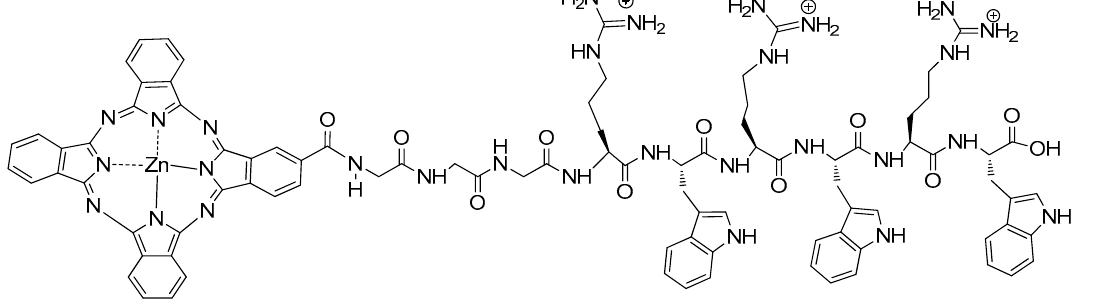
Figure 1. Chemical structure of CPZ-GGG(RW)3.